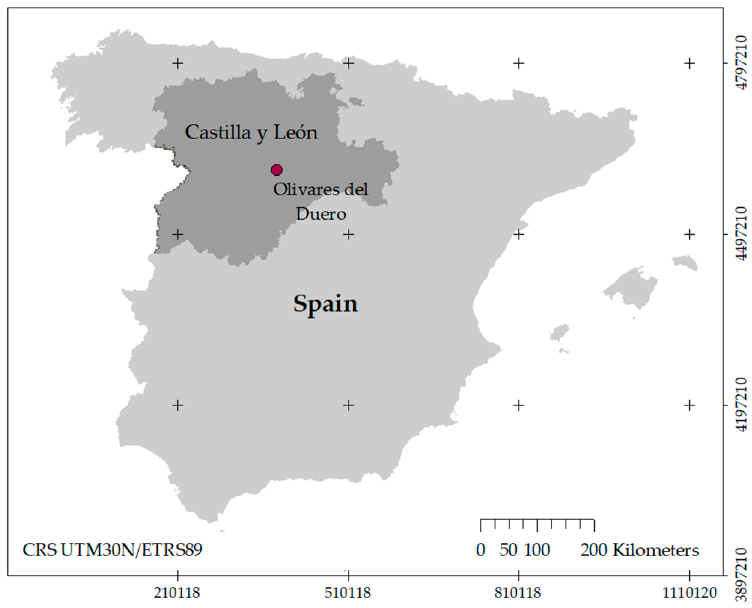
Figure 2. Olivares del Duero work area location, with center point coordinates 383800 4610100 CRS UTM30N/ETRS89.